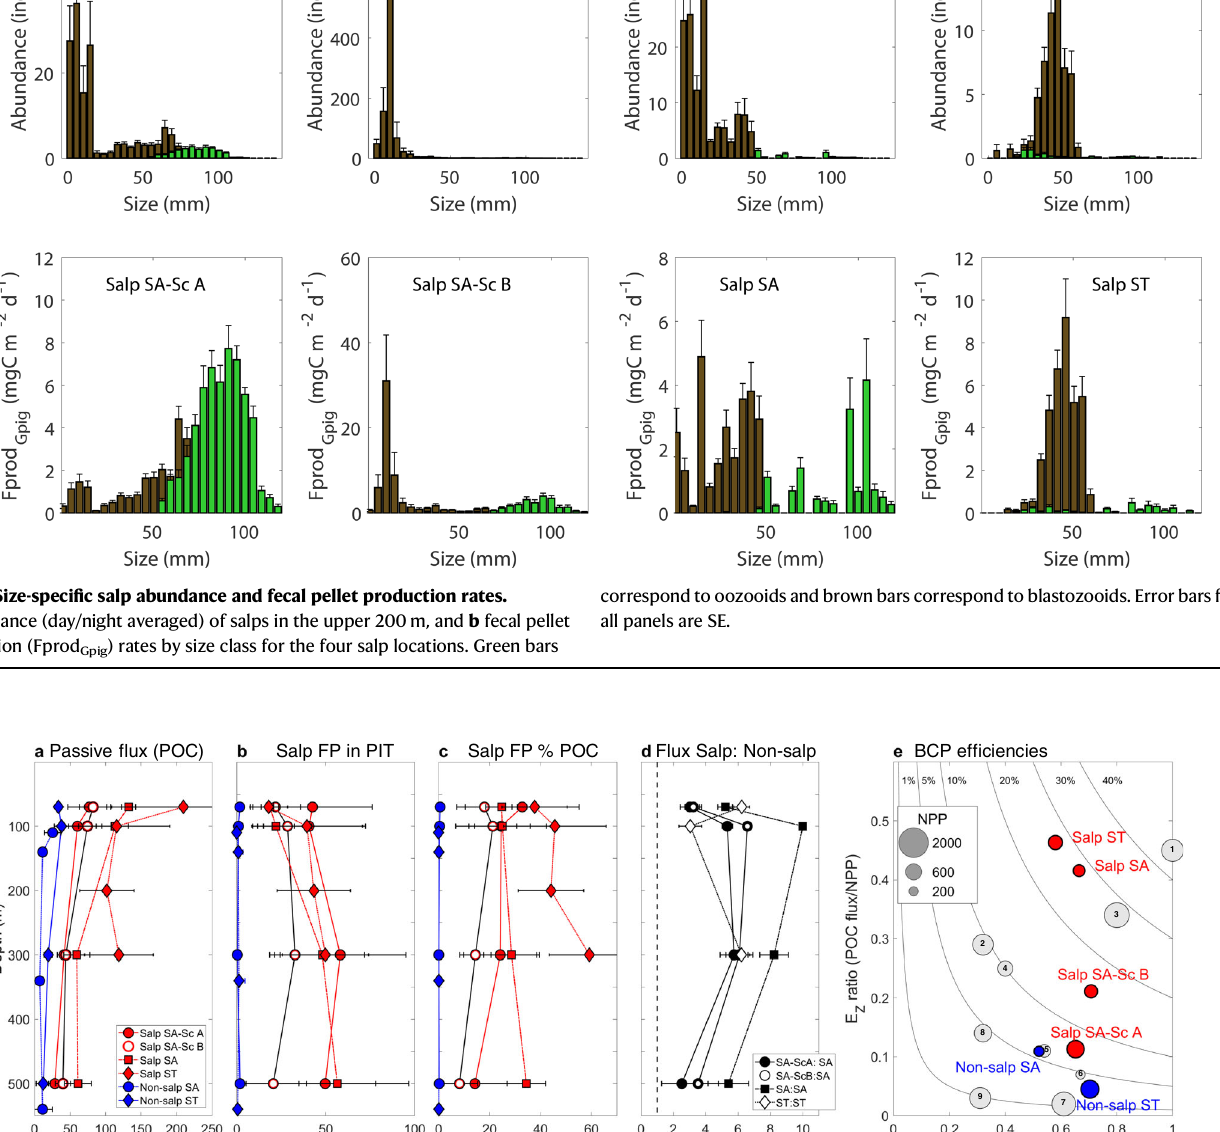
(spring, temperate North Atlantic), 2 — Kiwi 7, 3 — Kiwi 8 (Polar Front, Paci fi c sector, during the SalpPOOP